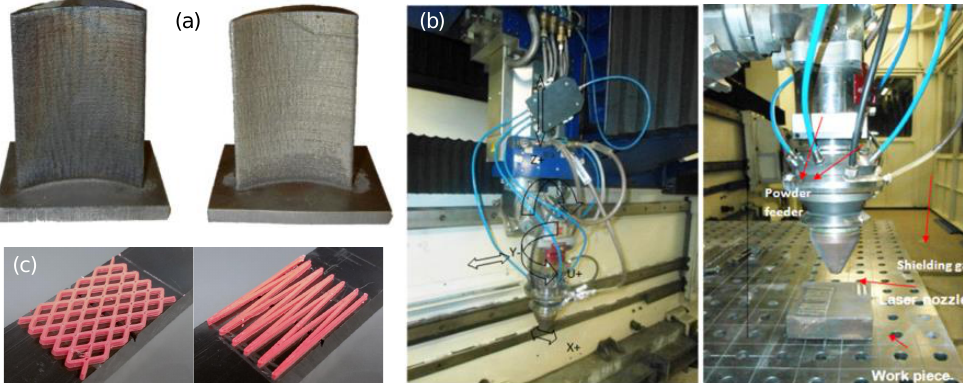
Figure 3. ( a ) Examples of damaged turbine blades repaired using laser engineered net shaping (LENS) [44], ( b ) example LENS repair setup [46], and ( c ) FFF-printed patches [49]. Panels ( a , b ) © El- sevier B.V., reproduced with permission. Panel ( c ) reproduced under the terms of a CC-BY